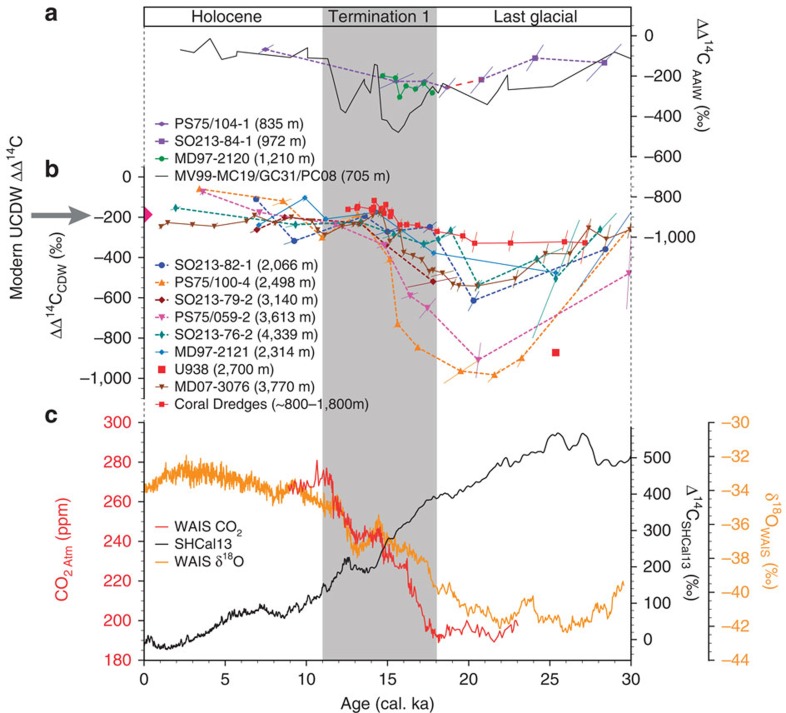
Comparison of oceanic and atmospheric proxy records.ΔΔ14C-values (ocean–atmosphere) of
(a) the intermediate Pacific region; PS75/104-1 and SO213-84-1 (this
study); MD97–2120 (ref. 15) (green line:
Bounty Trough); MV99-MC19/GC31/PC08 (ref. 12)
(black line: Northeast Pacific); (b) CDW
ΔΔ14C; PS75 and SO213 records (this study);
MD97–2121 (ref. 6) (light blue line: north
of Chatham Rise); U9385 (red square: Bounty Trough); Coral
dredges8 (red line: Drake Passage); MD07-3076 (ref.
4 (brown line: South Atlantic); and Modern
SW-Pacific UCDW ΔΔ14C (ref. 67) (pink triangle). (c) Atmospheric CO2
concentrations1 (red line); WAIS
δ18O record69 (orange line) and
atmospheric Δ14C-values20 (black line).
UCDW, Upper Circumpolar Deep Water.